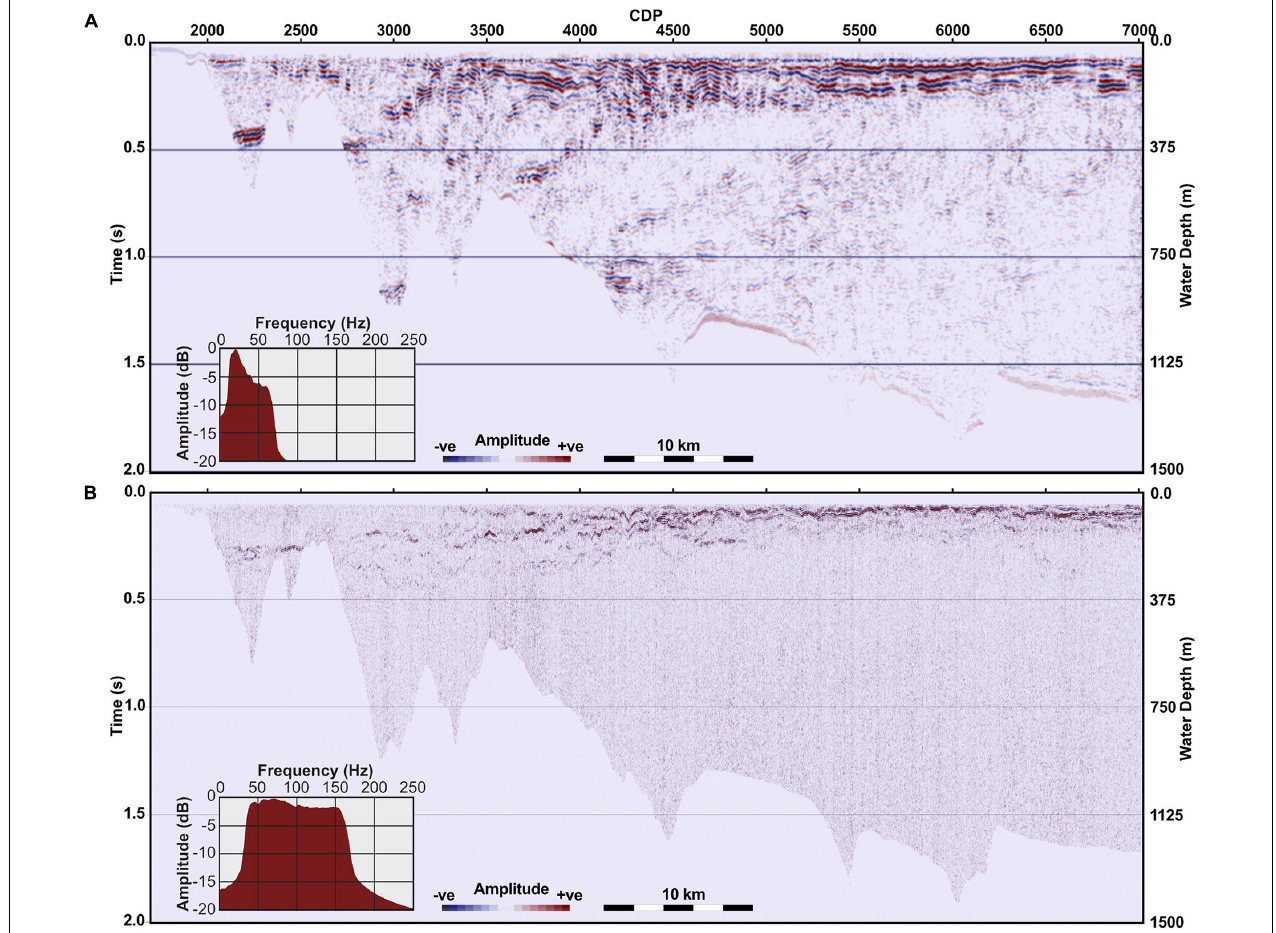
FIGURE 8 | Seismic data from the CB transect, showing comparison between (A) industry line CB82-94 collected in 1982 and (B) line KAH1201-5. Amplitude spectra calculated from water column reflectivity show the difference in frequency content of the two